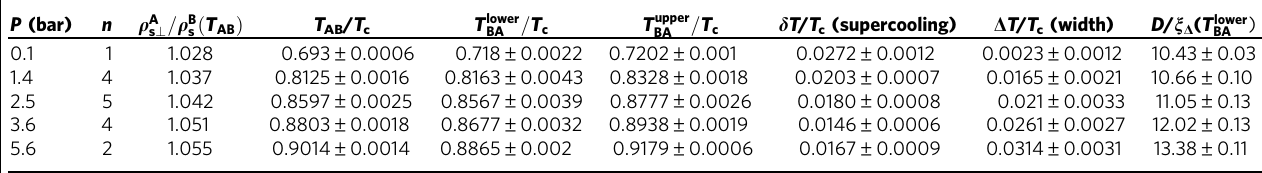
Table 1 | Measured properties of the A–B transition in a 1.08 l m slab.